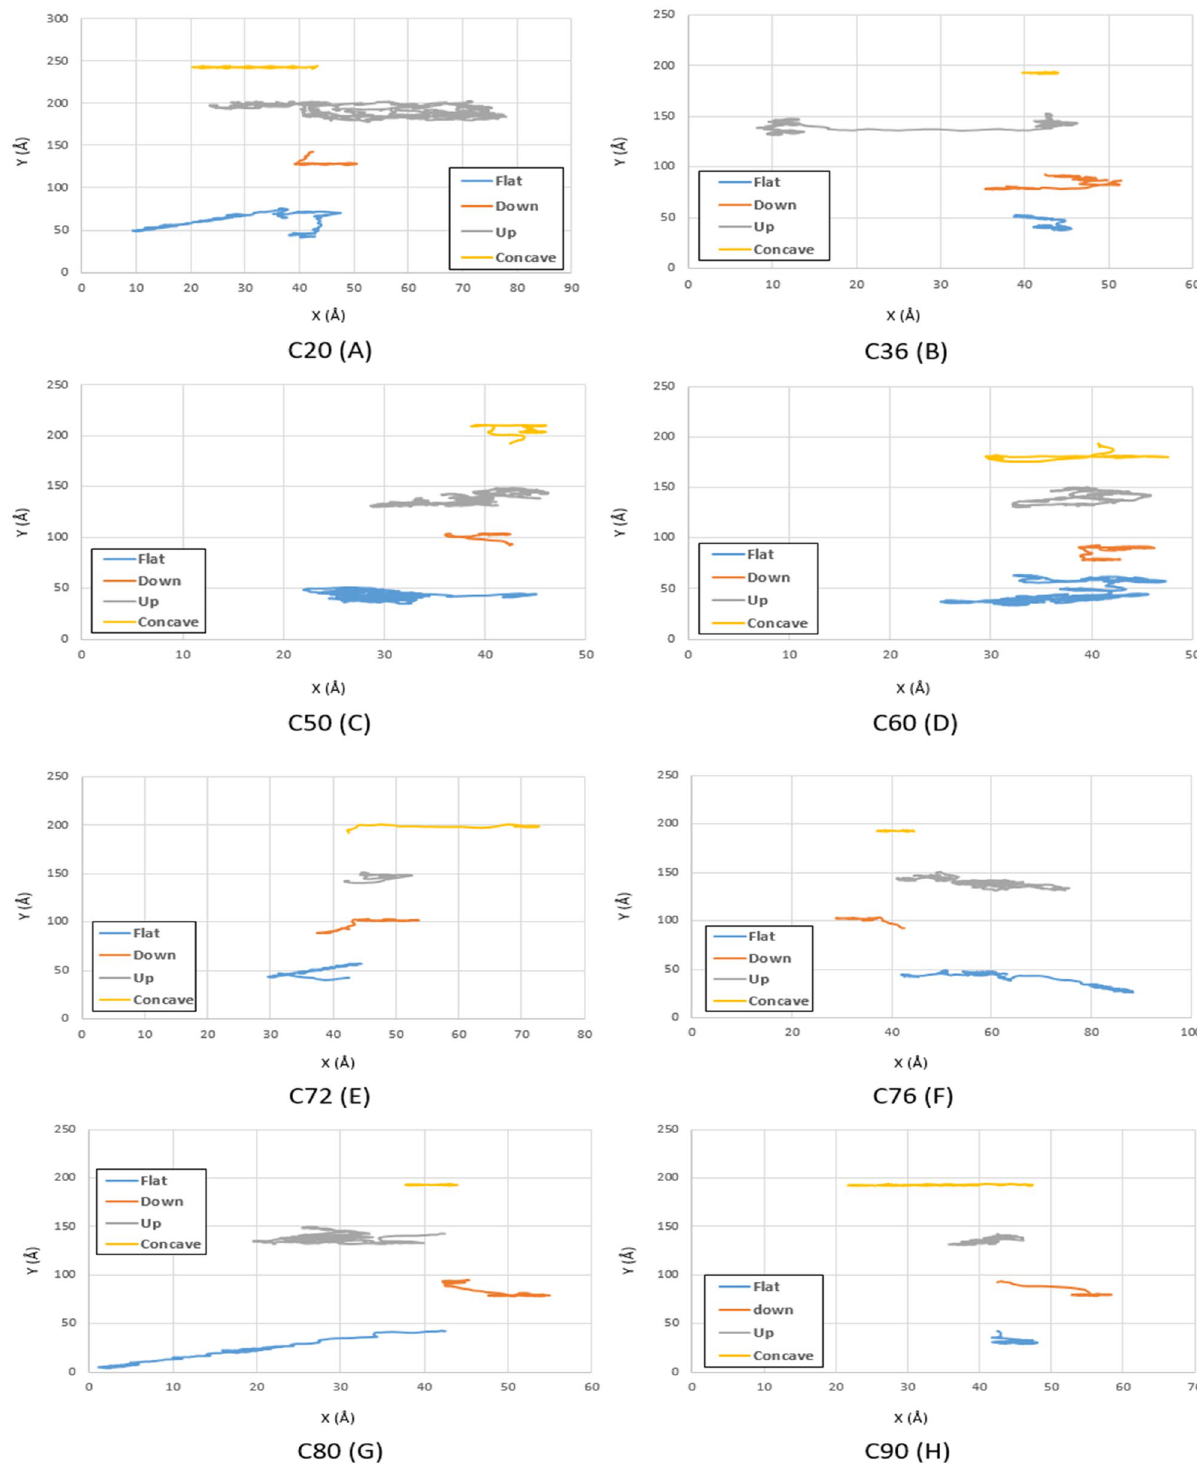
Figure 4. Trajectories of different fullerenes on a gold substrate at 150K for C 20 ( A ), C 36 ( B ), C 50 ( C ), C 60 ( D ), C 72 ( E ), C 76 ( F ), C 80 ( G ), and C 90 ( H ). The blue, red, black and yellow lines show the trajectories of the molecules on the flat, down side of the step, top side of the step, and concave substrates,